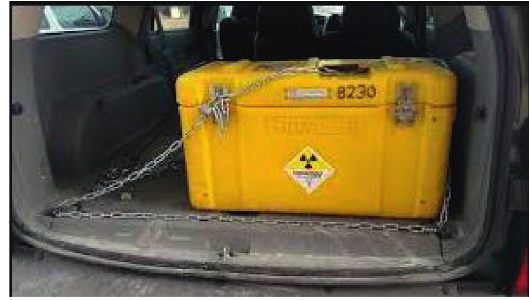
Figure 2: Radioactive material carrier